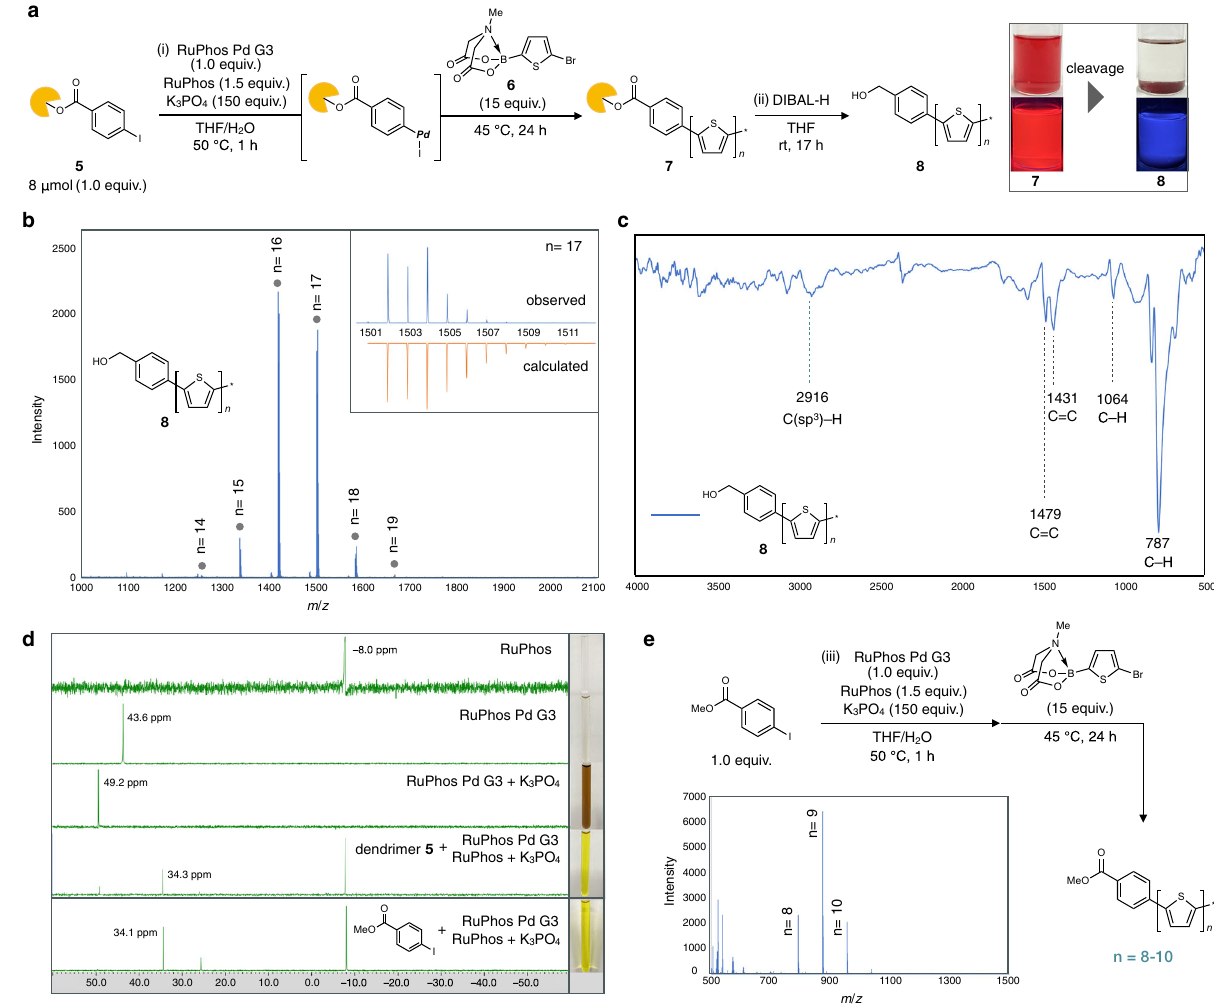
Fig. 3 | On-dendrimer synthesis of polythiophenes. a Synthesis of poly- thiophenes 7 and 8 .Reagentsandconditions:(i)RuPhosPdG3(1.0equiv.),RuPhos (1.5 equiv.), K 3 PO 4 (150 equiv.), THF/H 2 O, 50°C, 1h; then 6 (15 equiv.), 45°C, 24h; (ii) DIBAL-H (excess), THF, room temperature, 17h. Abbreviations: RuPhos Pd G3, (2-dicyclohexylphosphino-2 ′ ,6 ′ -diisopropoxy-1,1 ′ -biphenyl)[2-(2 ′ -amino-1,1 ′ -biphe- nyl)]palladium(II) methanesulfonate; RuPhos, 2-dicyclohexylphosphino-2 ′ ,6 ′ -diiso- propoxybiphenyl; DIBAL-H, diisobutylaluminium hydride. Chloroform solution of dendrimer-ligated polythiophene 7 exhibited red color and orange fl uorescence